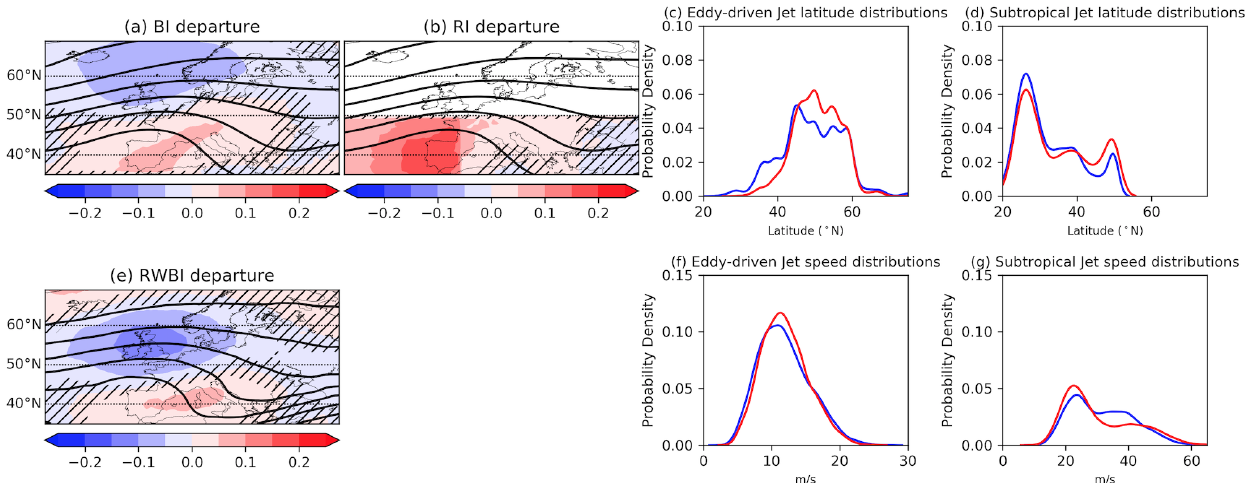
Figure 2. (a) Blocking index departure (shading) and composite Z500 (line contours), (b) ridge index departure (shading) and composite Z500 (line contours), and (e) Rossby wave breaking index departure (shading) and composite θ 2PVU (line contours) for stagnant days over SW. In panels (a) , (b) and (e) , the blocking, ridge and Rossby wave breaking index frequencies are presented as departures from their annual climatological frequencies, respectively. (c) The climatological annual eddy-driven jet stream latitude distribution (blue) and jet latitude distribution during stagnant days (red). (f) As in panel (c) but for the speed of the eddy-driven jet stream. (d) The climatological annual subtropical jet stream latitude distribution (blue) and that during stagnation (red). (g) As in panel (d) but or the subtropical jet speed. Hatching in panels (a) , (b) and (e) denotes where there is no statistical significance ( p > 0 . 01) calculated using a Monte Carlo approach (see text). Data source: ERA5 reanalysis during 1979–2018.